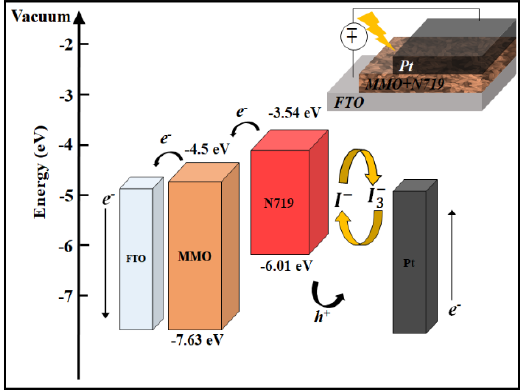
Figure 5. Energy band diagram of MMO and dye N719.